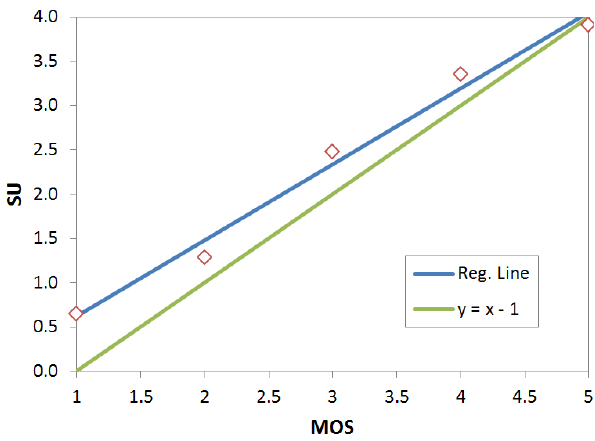
Figure 6. Scatter diagram for MOS versus scientific utility and estimated regression line.